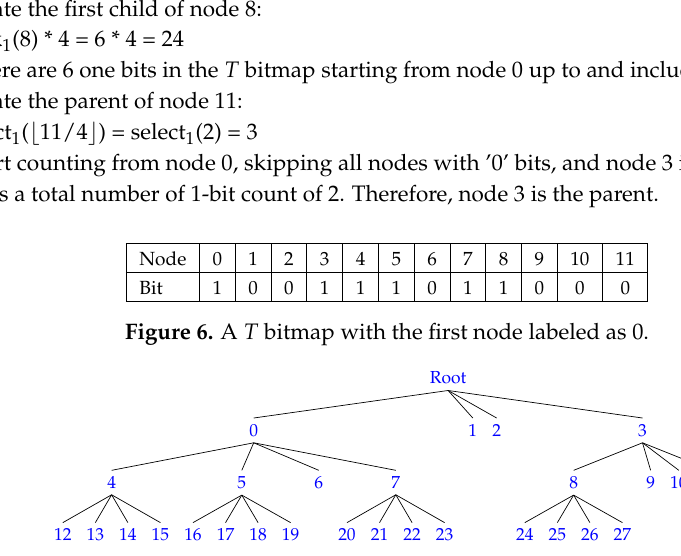
Figure 7. An example showing how the rank function is computed to obtain the children’s position on a k 2 -tree node (k=2) based on the tree in Figure 2. It starts with 0 on the first child of the root (first level) and the numbering traverses from left to right and from top to